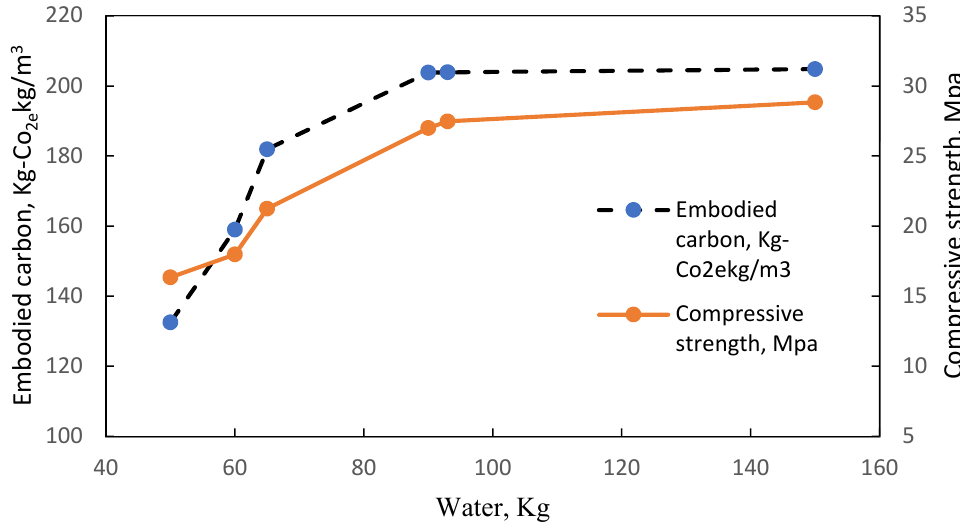
Figure 14. LCC at optimal water content of 80-95 litres per m 3 of concrete Batch C [32].